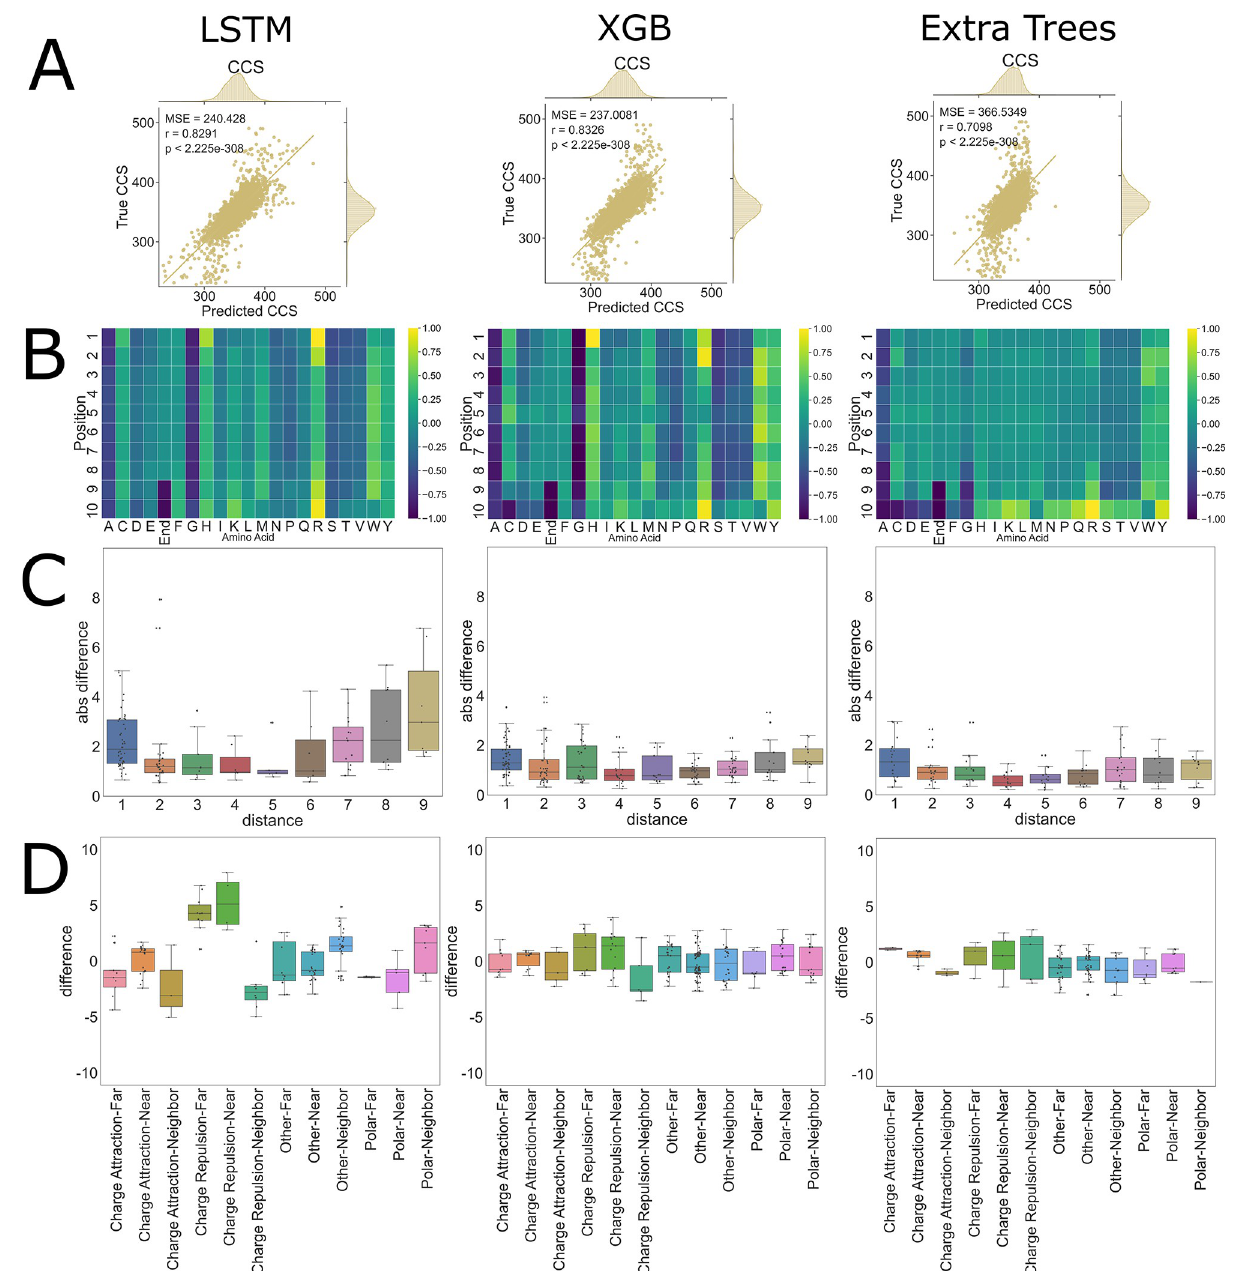
Fig 8. CCS PoSHAP of Various Machine Learning Models. PoSHAP analysis was performed on two additional machine learning models, Extra Trees, and Extreme Gradient Boosting (XGB). (A) Predictions were plotted against experimental values and the Mean Squared Error and r values are reported for each model. (B) PoSHAP heatmaps were created for each model, standardized by the highest value in each heatmap, illustrating an increase in model complexity as more sophisticated models are used. Dependence analysis was performed on each model and the significant interactions are plotted by (C) distance and by (D) combined distance and interaction